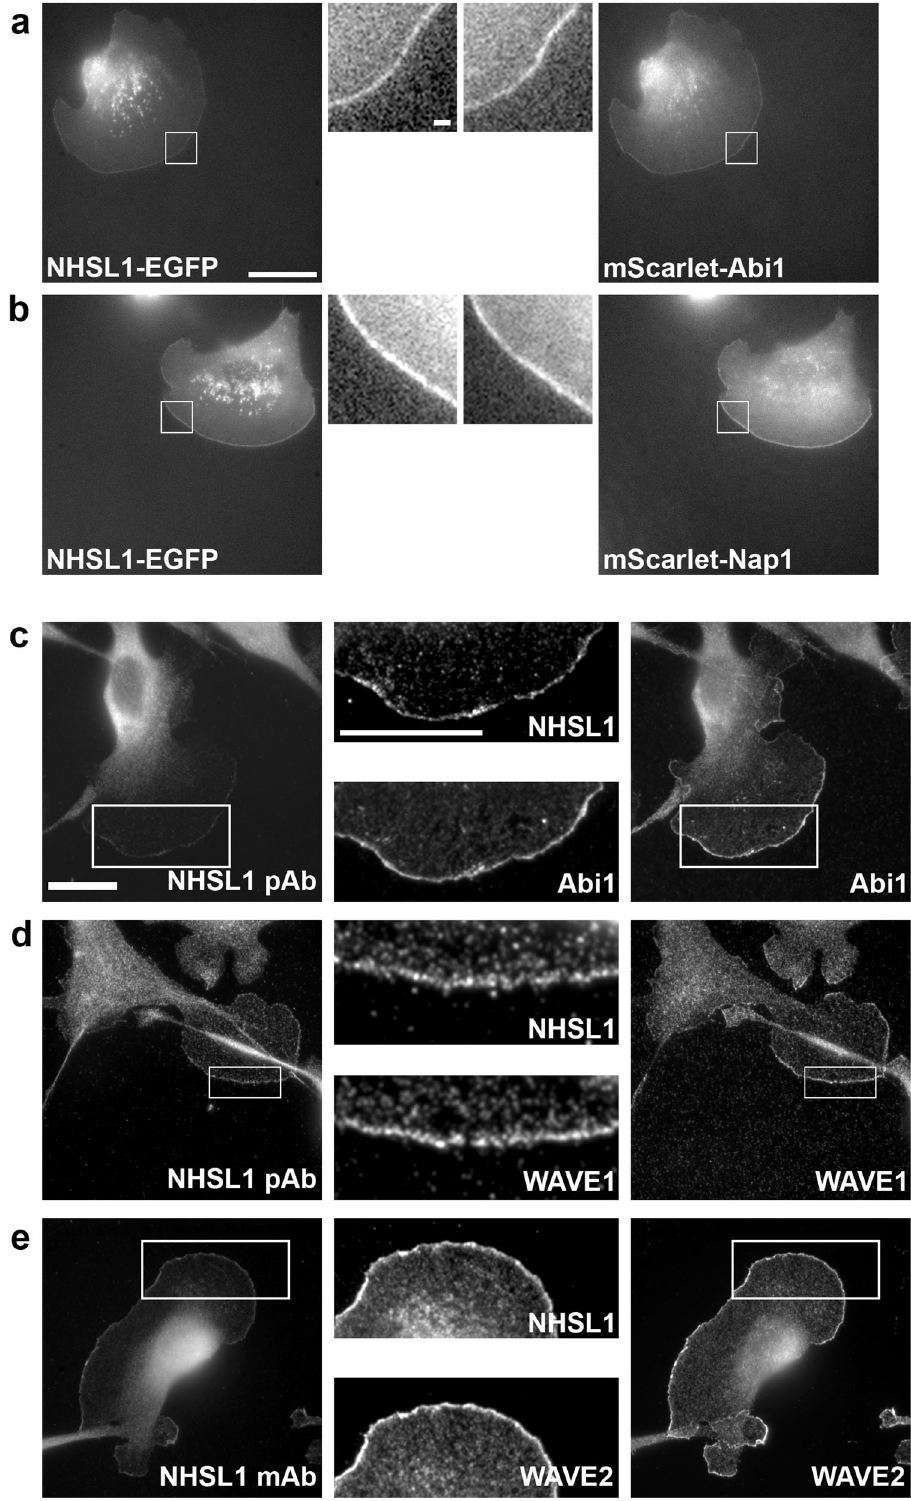
Fig. 4 NHSL1 co-localises with Abi and the Scar/WAVE complex. a Still images from live-cell imaging showing NHSL1-EGFP co-expressed with mScarlet- I-tagged Abi1 and b Nap1 in B16-F1 cells. Representative images shown from three independent experiments. Scale bar represents 20 µ m. Inset is a magni fi ed view of the white box. Scale bar in inset a applies to both insets a , b : 1.25 μ m. See also related Supplementary Movie 6. c – e Endogenous NHSL1 co-localises with Abi1 ( c NHSL1 pAb) Scar/WAVE1 ( d NHSL1 pAb), and Scar/WAVE2 ( e NHSL1 mAb) at the very edge of lamellipodia in B16-F1 mouse melanoma cells. Scale bar in c applies also to d , e : 20 µ m. Inset represents a magni fi ed view of the white box. Scale bar in the inset in c applies also to inset for d , e : 20 μ m. Representative images shown from three independent experiments. See Supplementary Fig. 8 for line scans of co-localisations in c and e .